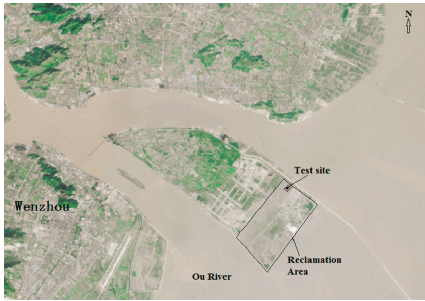
Figure 2: Location of the